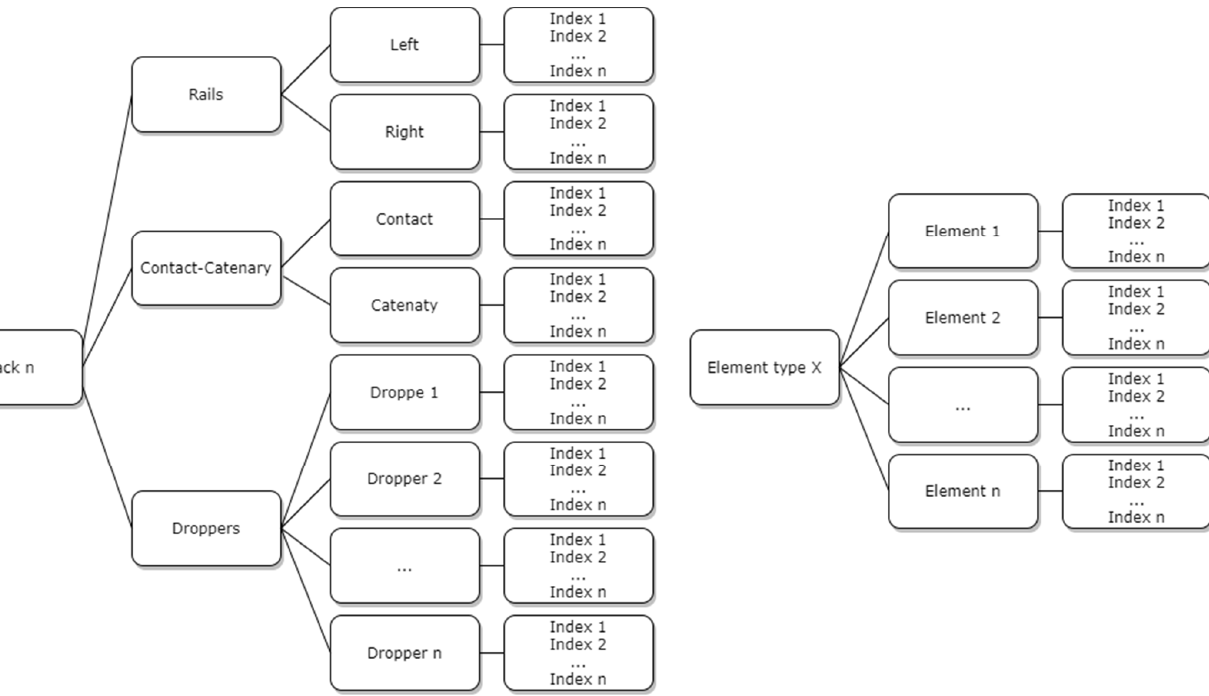
Figure 14. Output data structure: track n is the structure with the elements of the track number n in a 𝑪 𝒊 , formed by its rails, contact, catenary, and droppers. Element type X is a structure with all the elements in 𝑪 𝒊 of a certain class, namely, signs, traffic lights, marks, masts, or signs in masts.